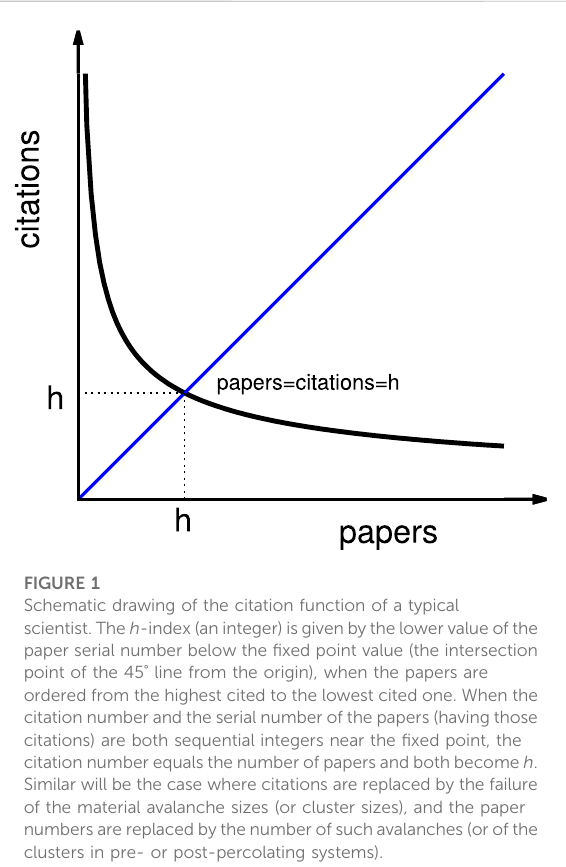
FIGURE 1 Schematic drawing of the citation function of a typical scientist. The h -index(an integer) isgivenbythelower valueofthe paper serial number below the fi xed point value (the intersection point of the 45 ° line from the origin), when the papers are ordered from the highest cited to the lowest cited one. When the citation number and the serial number of the papers (having those citations) are both sequential integers near the fi xed point, the citation number equals the number of papers and both become h . Similar will be the case where citations are replaced by the failure of the material avalanche sizes (or cluster sizes), and the paper numbers are replaced by thenumber of suchavalanches (orof the clusters in pre- or post-percolating systems).